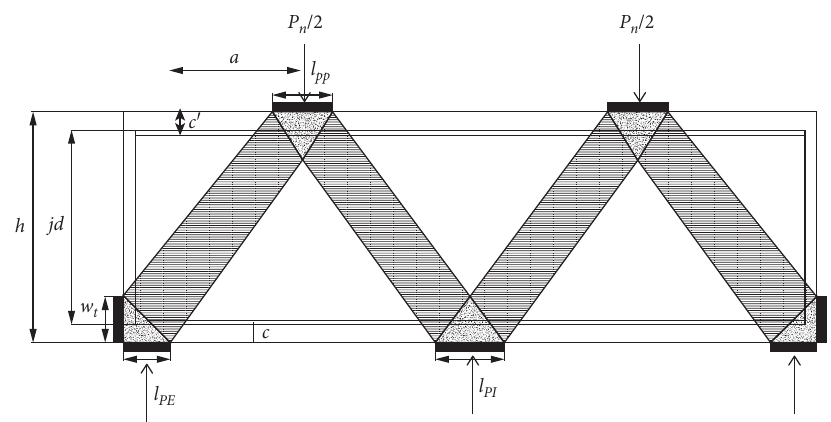
Figure 10: Graphic STM for continuous RC deep beams [19, 33].